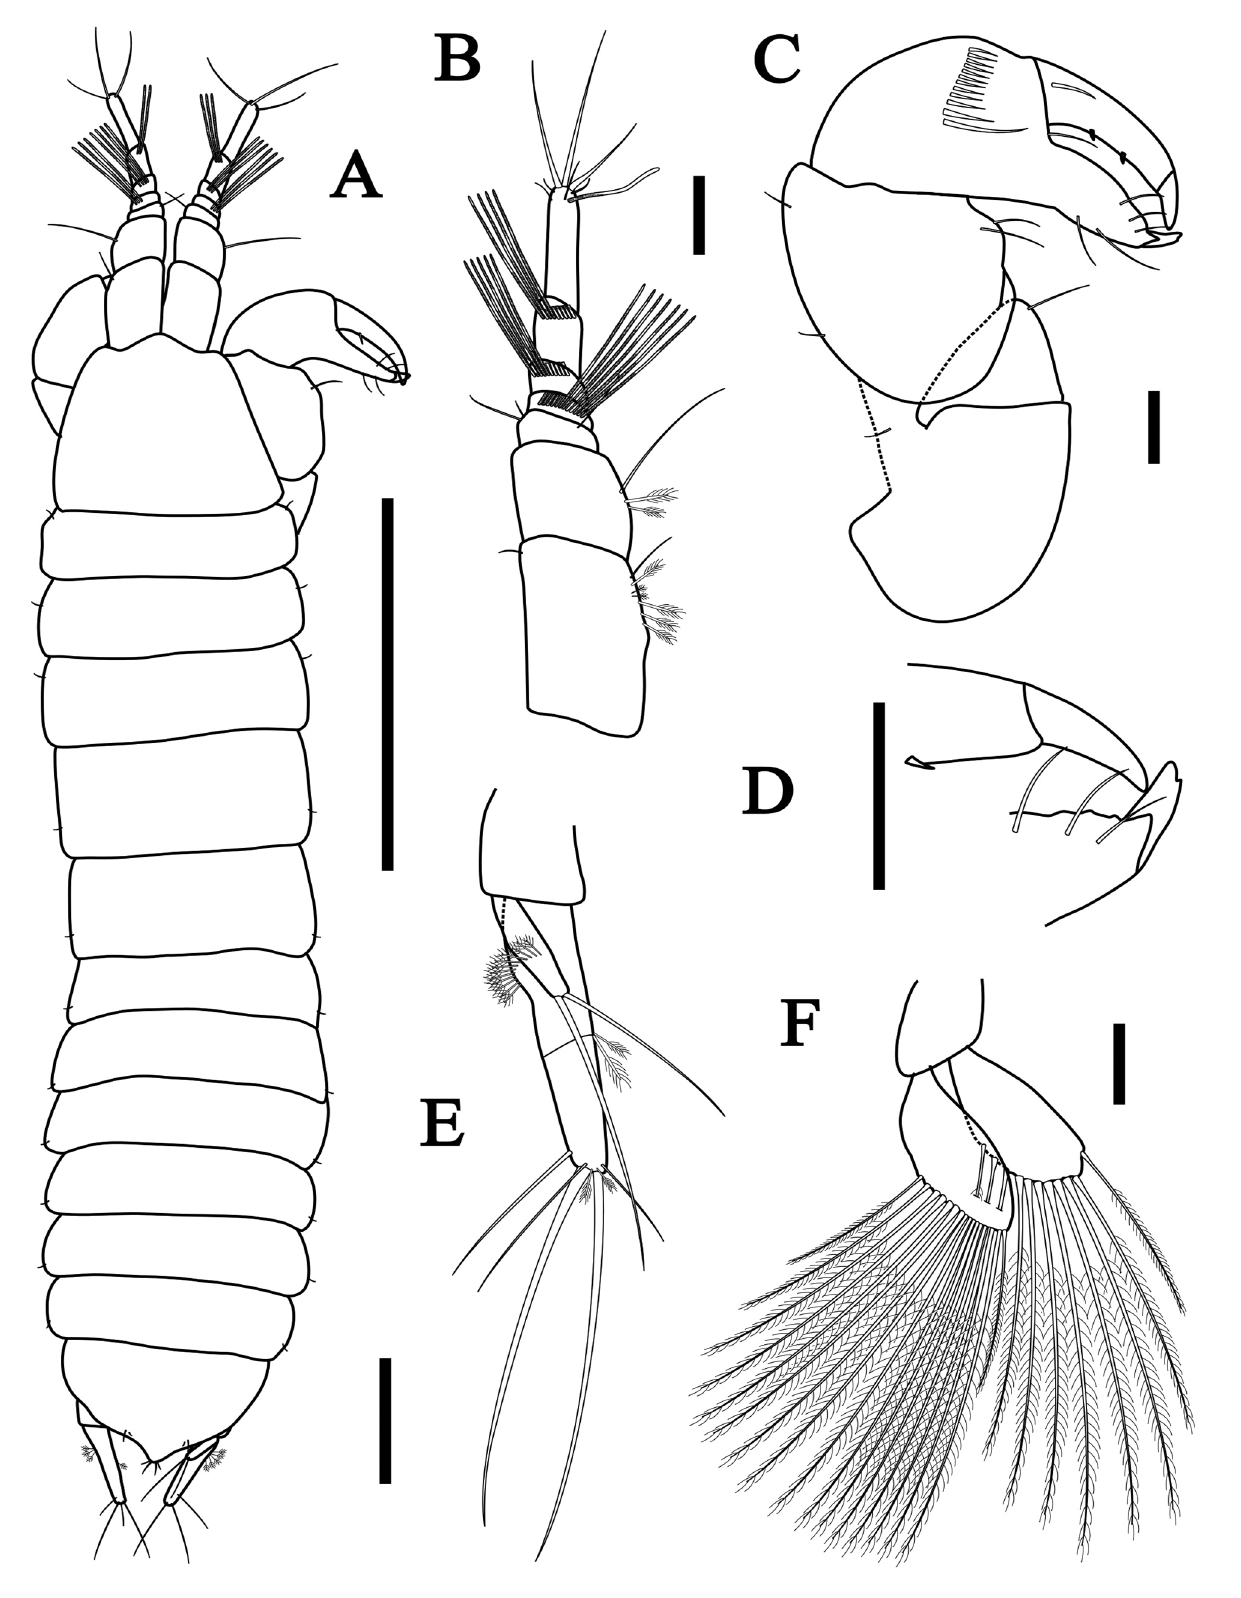
Figure 6. Tanaopsis brevicorpus sp. nov., male paratype, length 3.2 mm, MNRJ 25192. A, dorsal view; B, antennules; C, cheliped, with D, detail of cheliped fixed finger; E, uropod; F, pleopod. Scale bars: A = 1 mm; B-F = 0.1